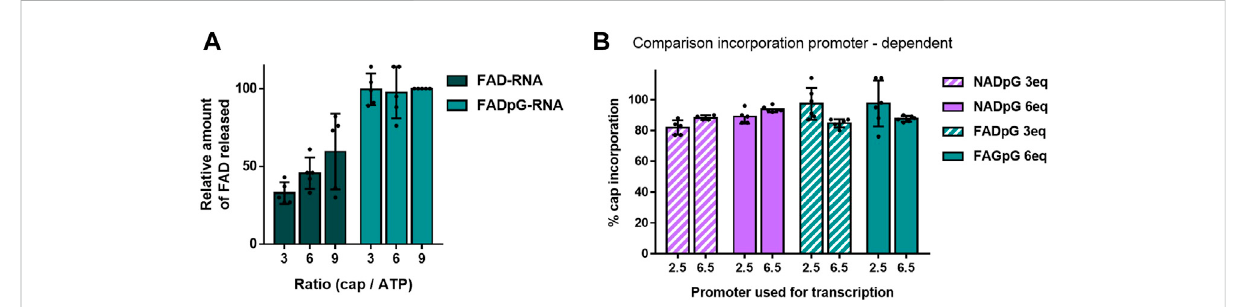
FIGURE 6 (A) Capping ef fi ciencies of FAD- and FADpG-RNAs determined using the FAD-capQ method (using 9x excess FADpG). (B) Capping ef fi ciencies obtained for NADpG and FADpG (both quanti fi cation methods included) as a function of the T7 promoter.